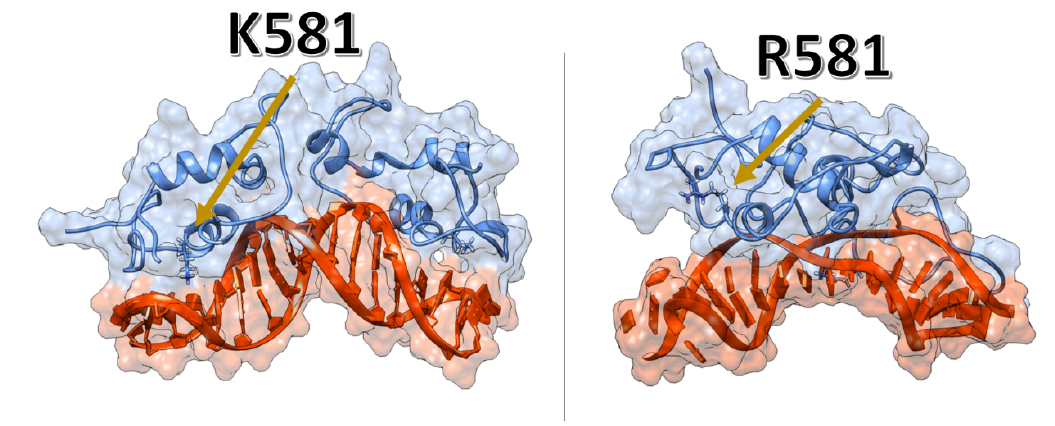
Figure 5. K581R mutant weakens the interactions between the protein and the DNA-ARE. Left panel—the average configuration sampled from the WT simulations. Right panel—the pocket formed between the AR-DBD and the DNA-ARE, wherein R581 is located.